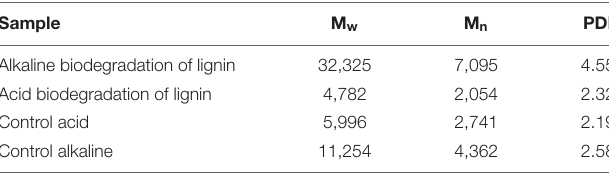
TABLE 3 | Molar mass characterization of lignin samples.